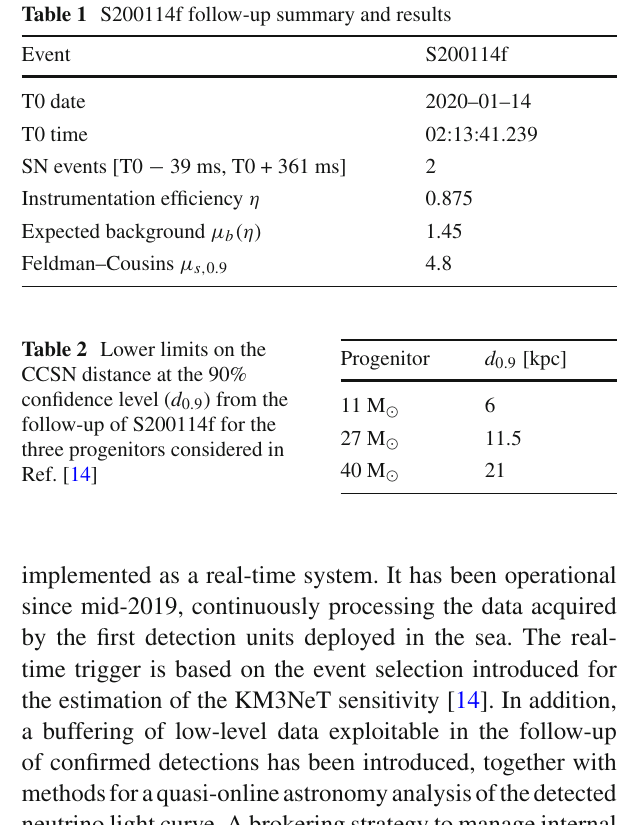
Table 1 S200114f follow-up summary and results